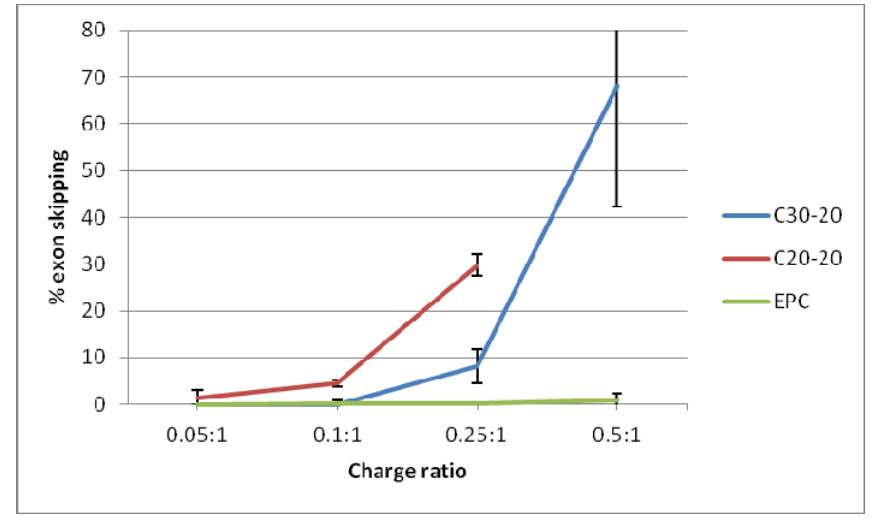
Figure 6. Comparison of lipoplex formulations (EPC/Chol/PMO, C30-20/Chol/PMO and C20-20/Chol/PMO at 250 nmol/L) to produce exon 45 skipping in hSkMCs over a range of charge